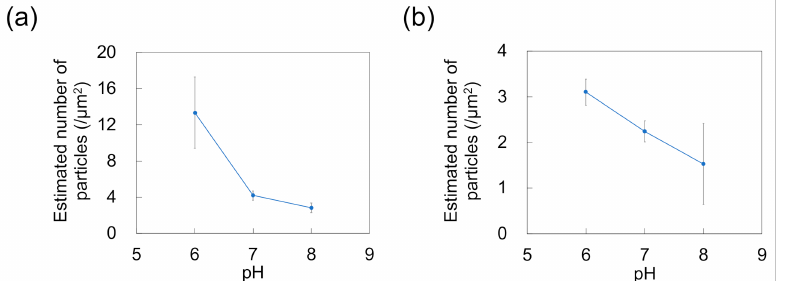
Figure 3. Effect of pH on the number of particles adsorbed on polydimethylsiloxane-based substrates immersed in dispersions of ( a ) 100-nm and ( b ) 250-nm nanoparticles ( n = 5). Error bars indicate the standard deviation.